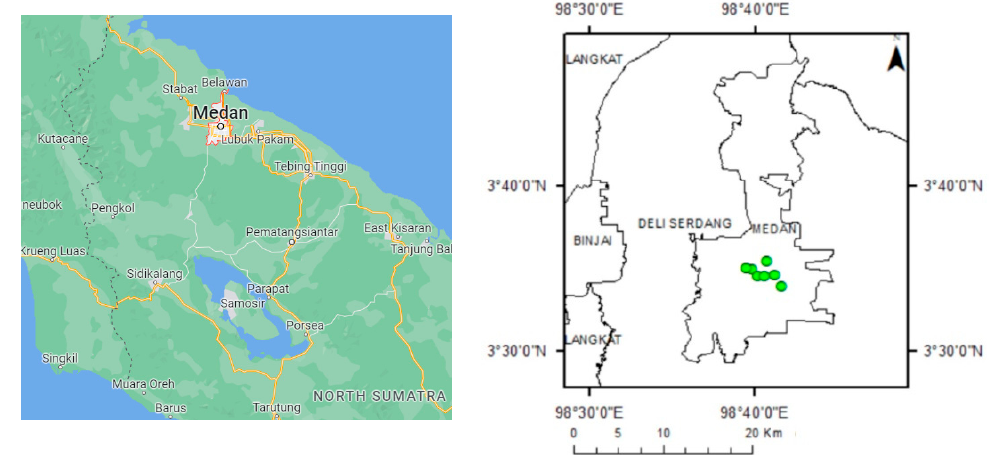
Figure 1. Research Site Map (the green symbols indicate the location of the studied urban parks). (Source: Google map (left)).